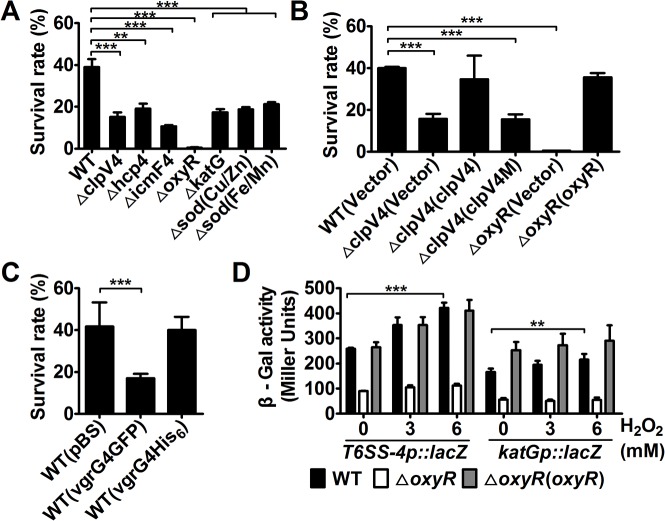
T6SS-4 is essential for Yptb survival under oxidative stress.
A-C. Indicated bacterial strains grown to mid-exponential phase were exposed to H2O2 for 1 hour and the viability of the cells was determined. Note that the clpV4M mutant defective in ATPase activity failed to complement the clpV4 mutant. D. Oxidative stress induced the expression of T6SS-4. Cells of relevant Yptb strains harboring P
T6SS-4::lacZ or P
katG::lacZ were treated with indicated amounts of H2O2 and the expression of the reporter was measured. Data shown were the average of three independent experiments; error bars indicate SD from three independent experiments. ***, p<0.001; **, p<0.01.